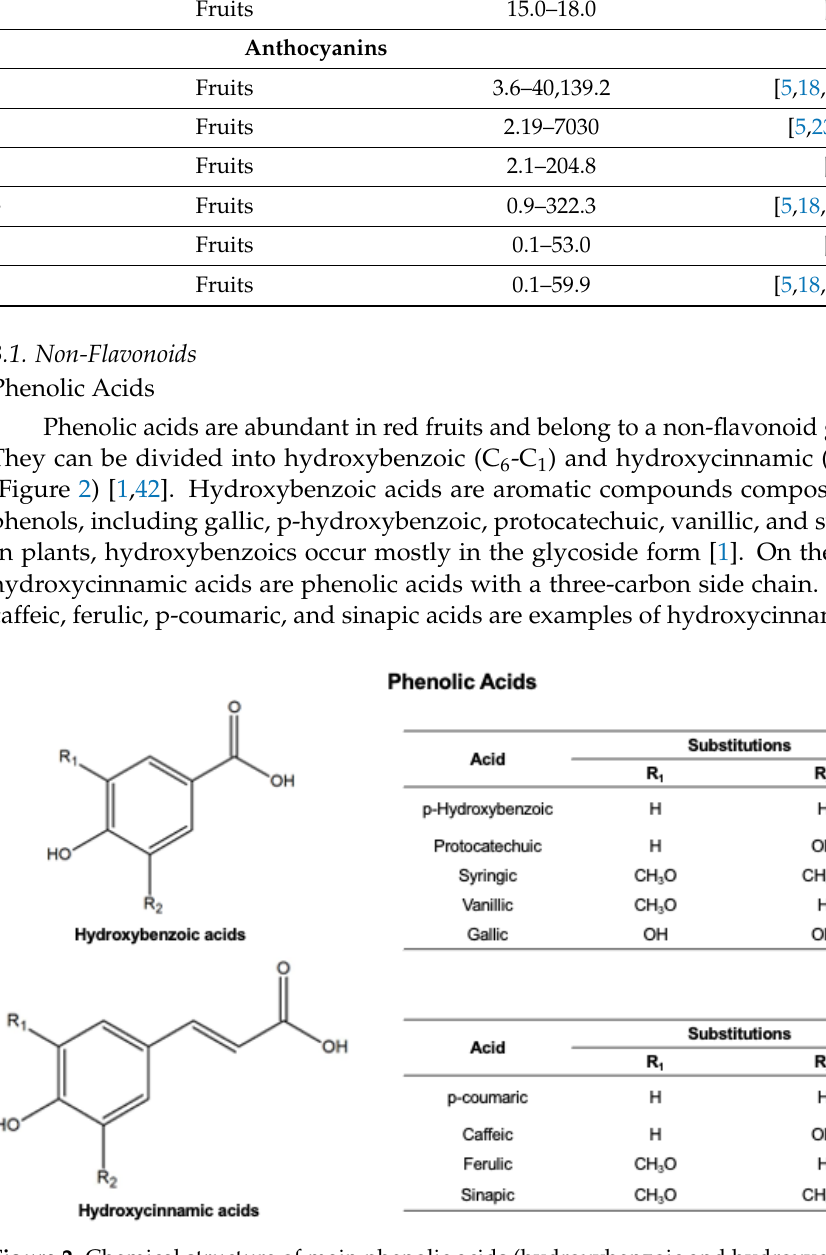
Figure 2. Chemical structure of main phenolic acids (hydroxybenzoic and hydroxycinnamic acids) found in Prunus avium L.